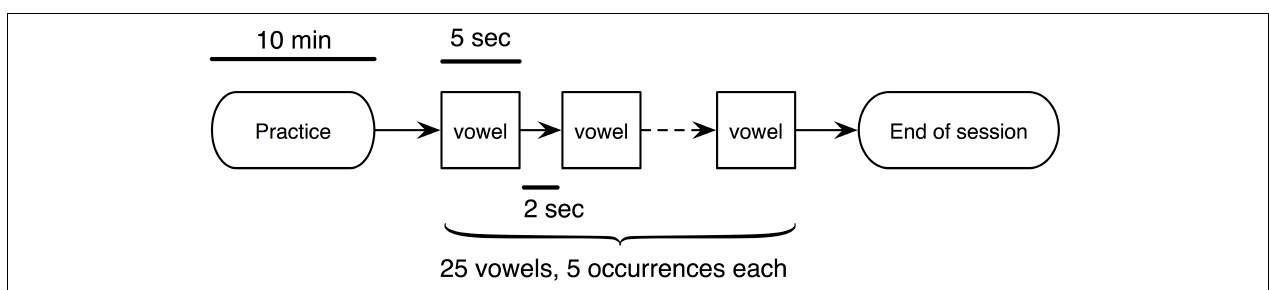
FIGURE 4 | The experimental procedure for testing the quality of vowel synthesis. Two sessions (Cartesian or polar) were given to each subject. Both the healthy subjects and patients received the 10-min practice for familiarizing with the